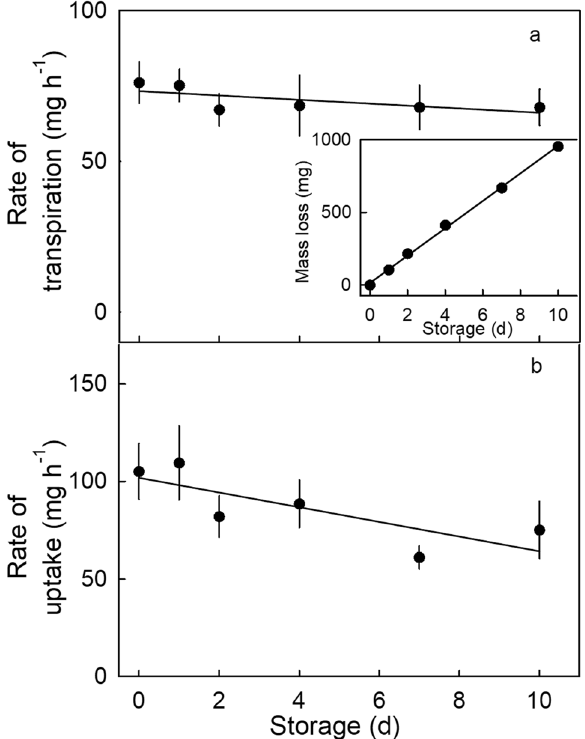
Figure 8. Effect of cold storage duration on ( a ) the rate of transpiration (main graph), mass loss (inset), and ( b ) the rate of water uptake of ‘Clery’ strawberry following storage.